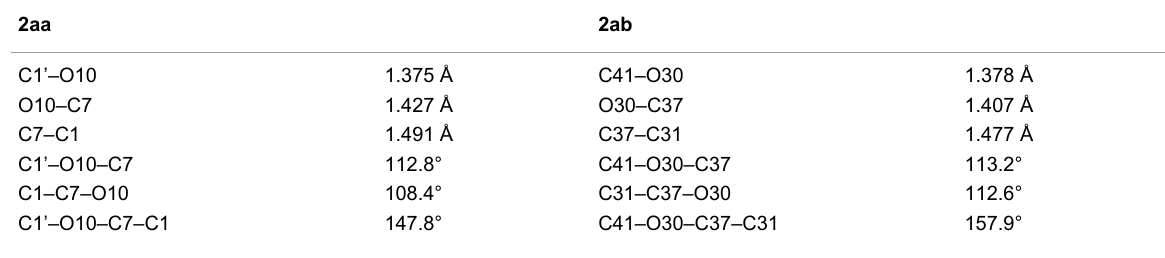
Table 4: Selected corresponding distances and angles of 2aa and 2ab .